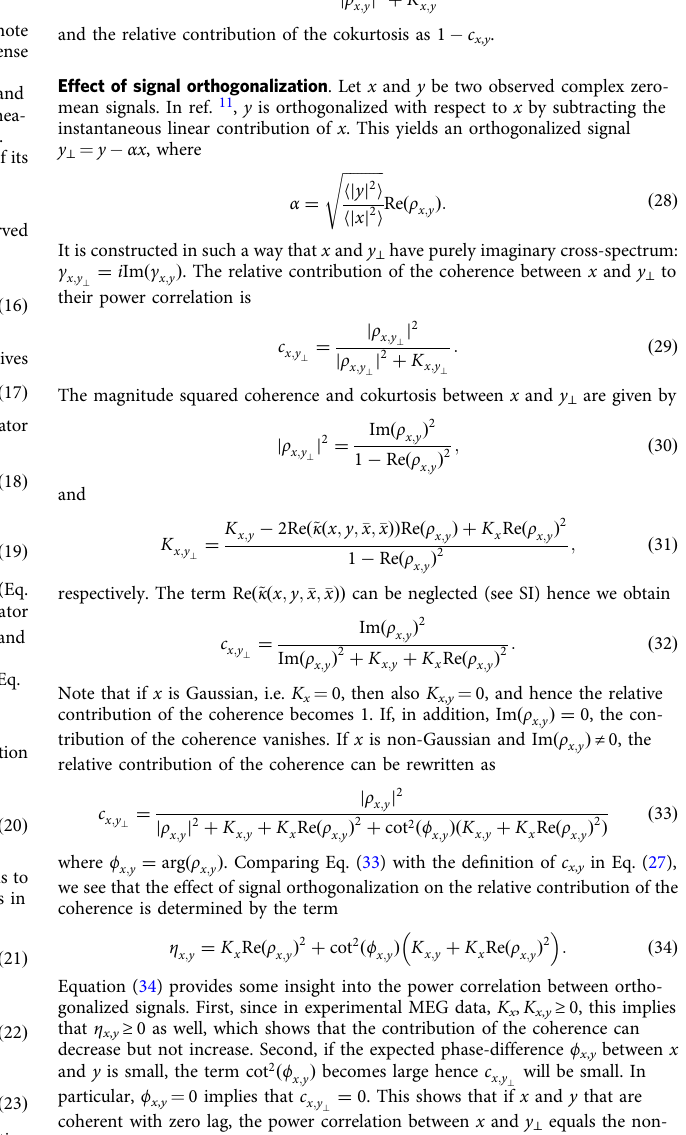
h xy i ffiffiffiffiffiffiffiffiffiffiffiffiffiffiffiffiffiffiffiffiffi hj x j 2 ihj y j 2 i